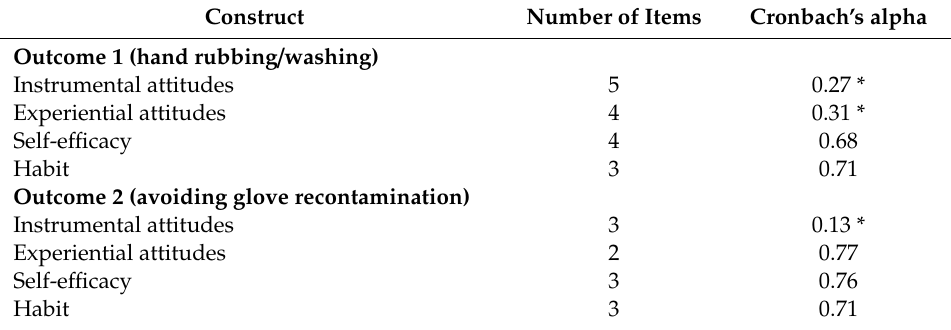
Table 1. Reliability of psychological constructs measured with Likert-like response